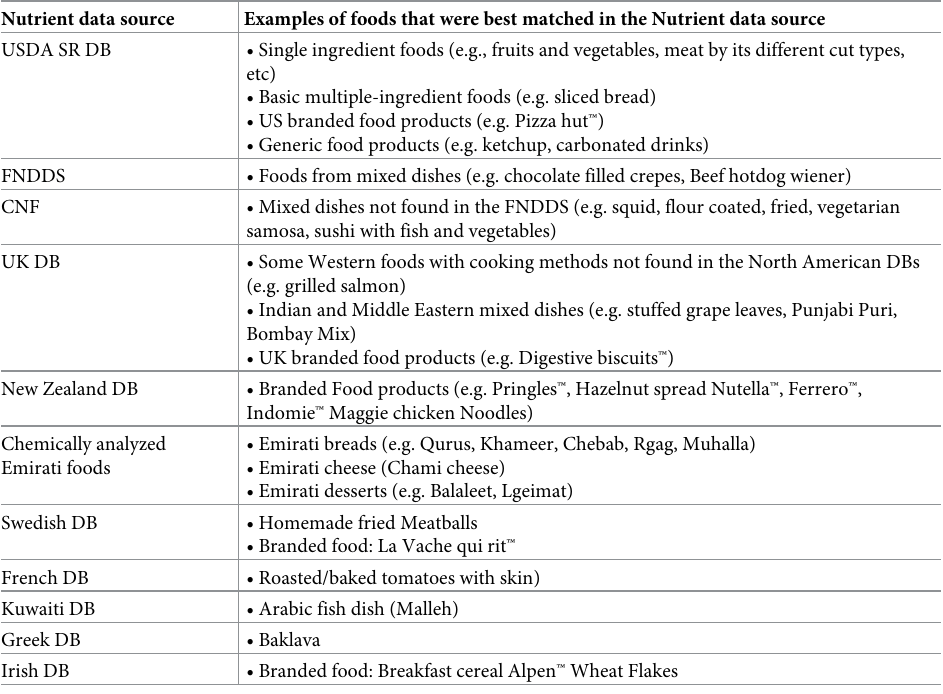
Table 2. Nutrient data sources and their contribution to the matching of the 532 foods reported in the survey. Nutrient data